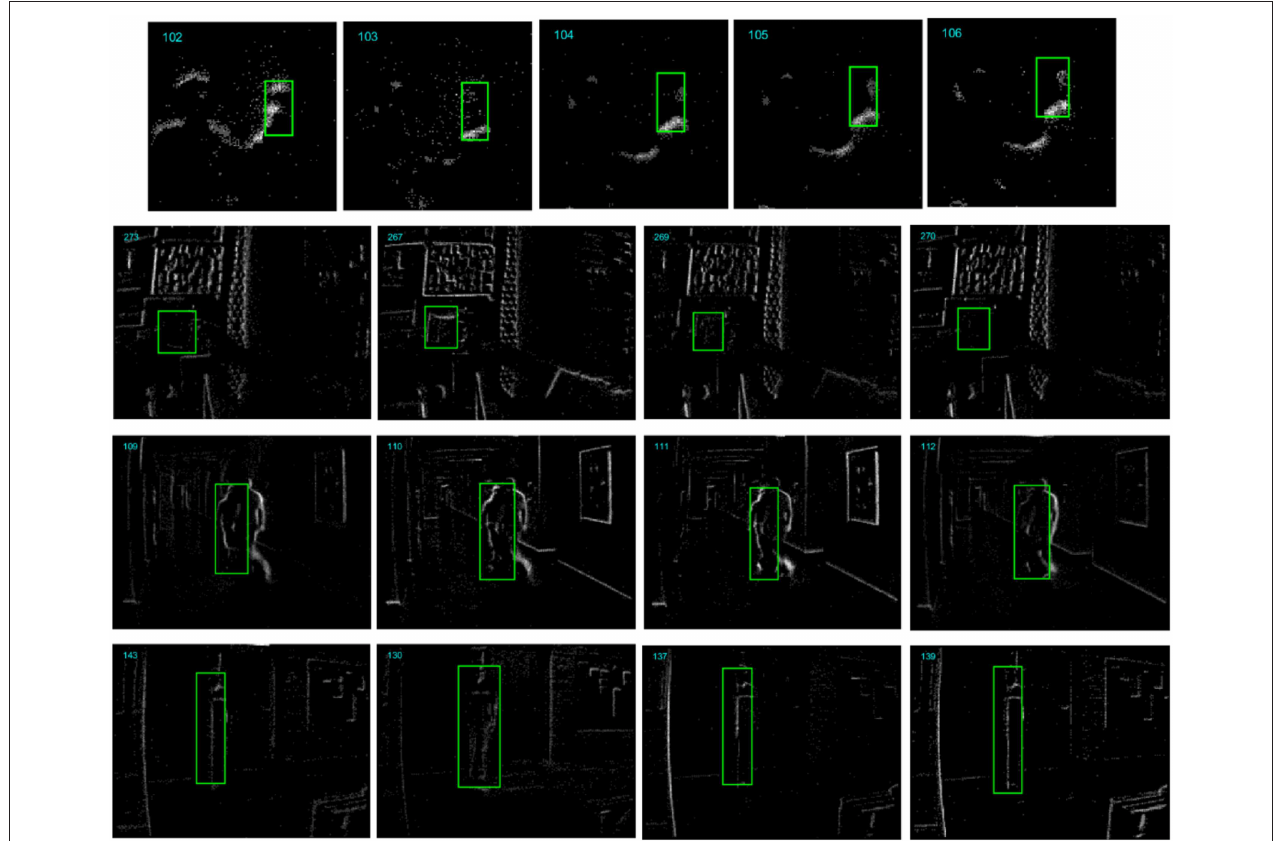
FIGURE 1 | Some example reconstructed frames from several event-stream recordings (From top to bottom are the “Horse toy” from DVS128 sensor, “Vid_B_cup,” “Vid_J_person_floor,” and “Vid_E_person_part_occluded” from DAVIS sensor). The appearance of the target object (in bounding box with green line) changes obviously for the noise events, background texture, and randomness in event-generating of the